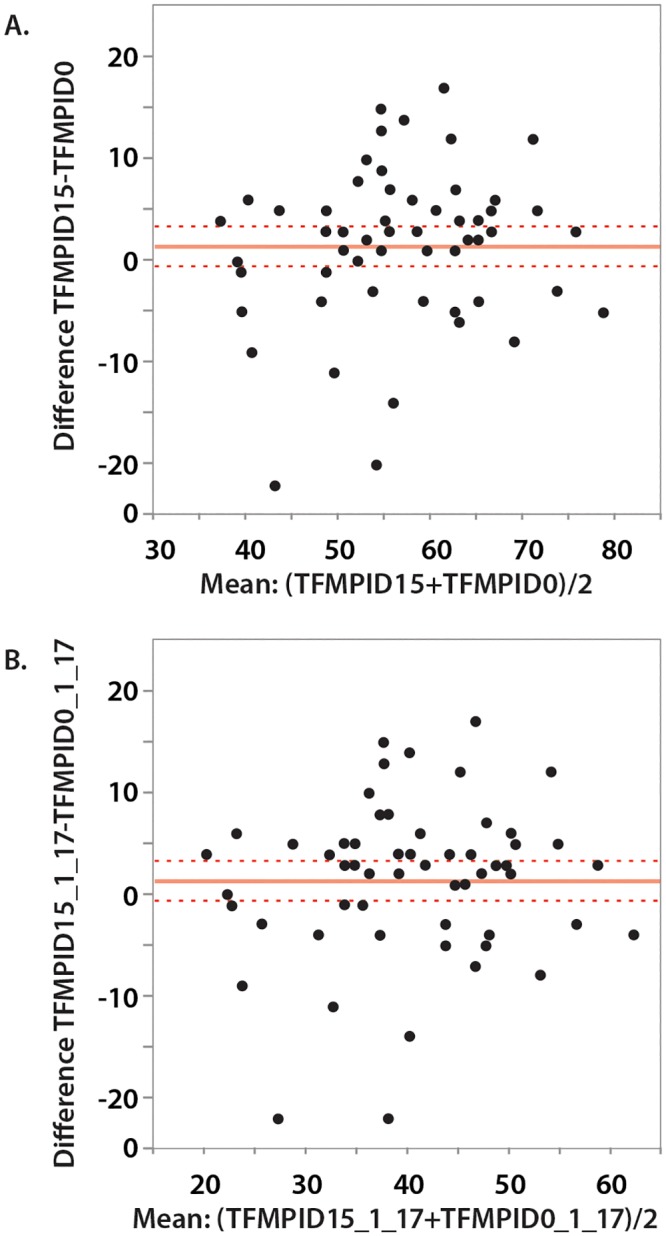
Bland-Altman plots of the FMPI for 17 items (A) and 19 items (B).